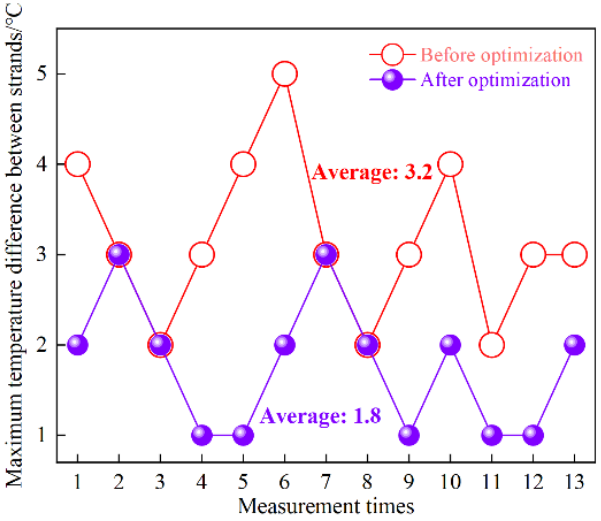
Figure 7. Maximum temperature difference among strands before and after tundish optimization.